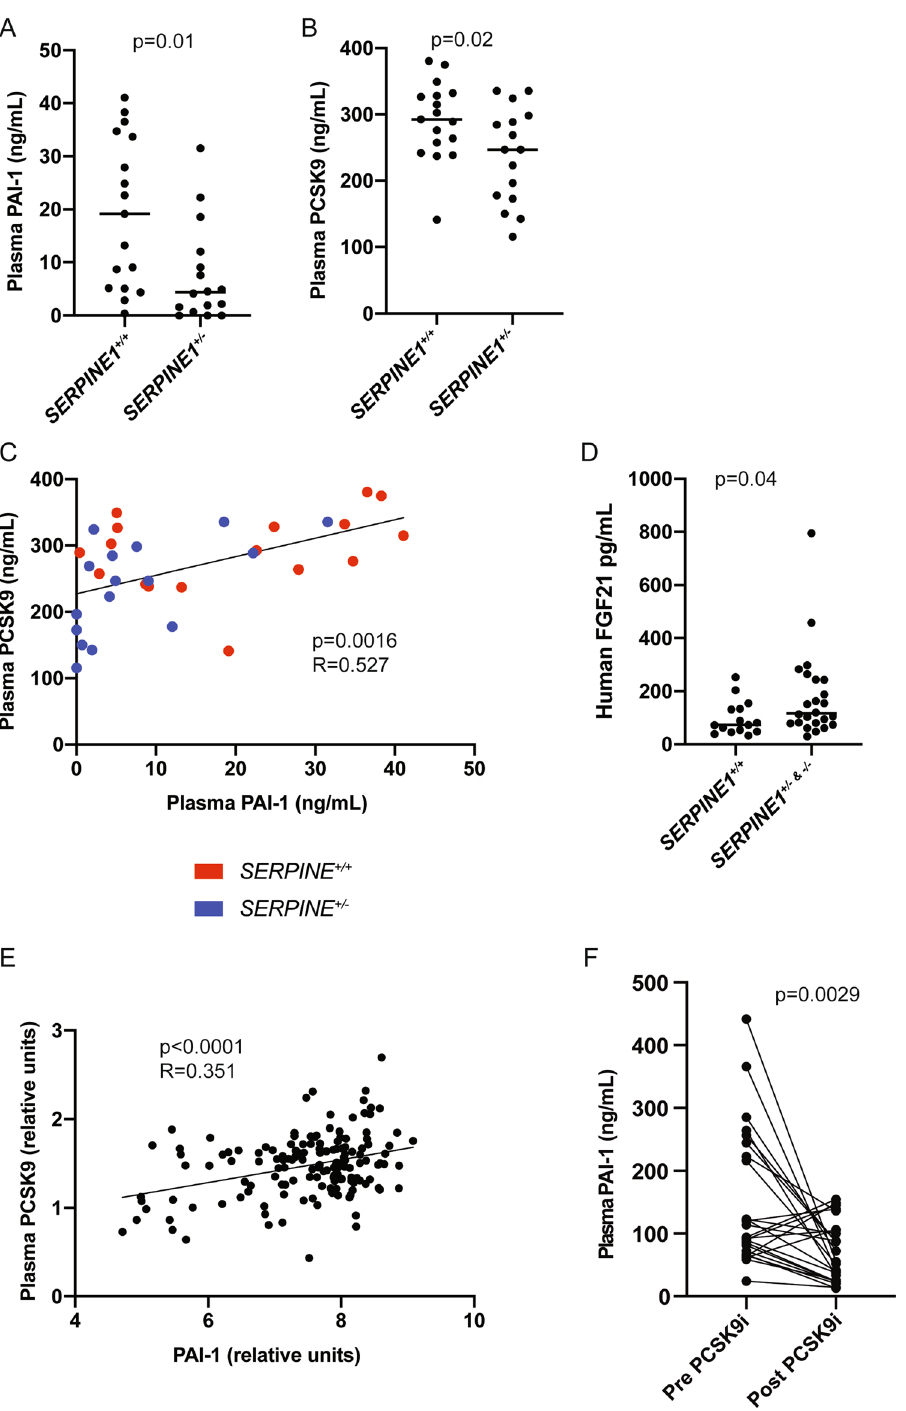
Figure 5. Plasma PCSK9 levels correlate with PAI-1 in humans. Characterization of the Amish cohort human plasma [( A ) PAI-1 levels, ( B ) PCSK9 levels, ( C ) correlation between plasma PAI-1 vs. plasma PCSK9 levels, and ( D ) FGF21 levels] (values are express as mean ± SEM (n = 7 affected, 16 carriers , 17 unaffected). ( E ) Relationship between PCSK9 and PAI-1 levels in a separate cohort of HFpEF patients, values are express as mean ± SEM (n = 147). ( F ) PAI-1 levels in human plasma from a cohort of patients with hyperlipidemia before and during treatment with a PCSK9 inhibitor (values are express as mean ± SEM, n =